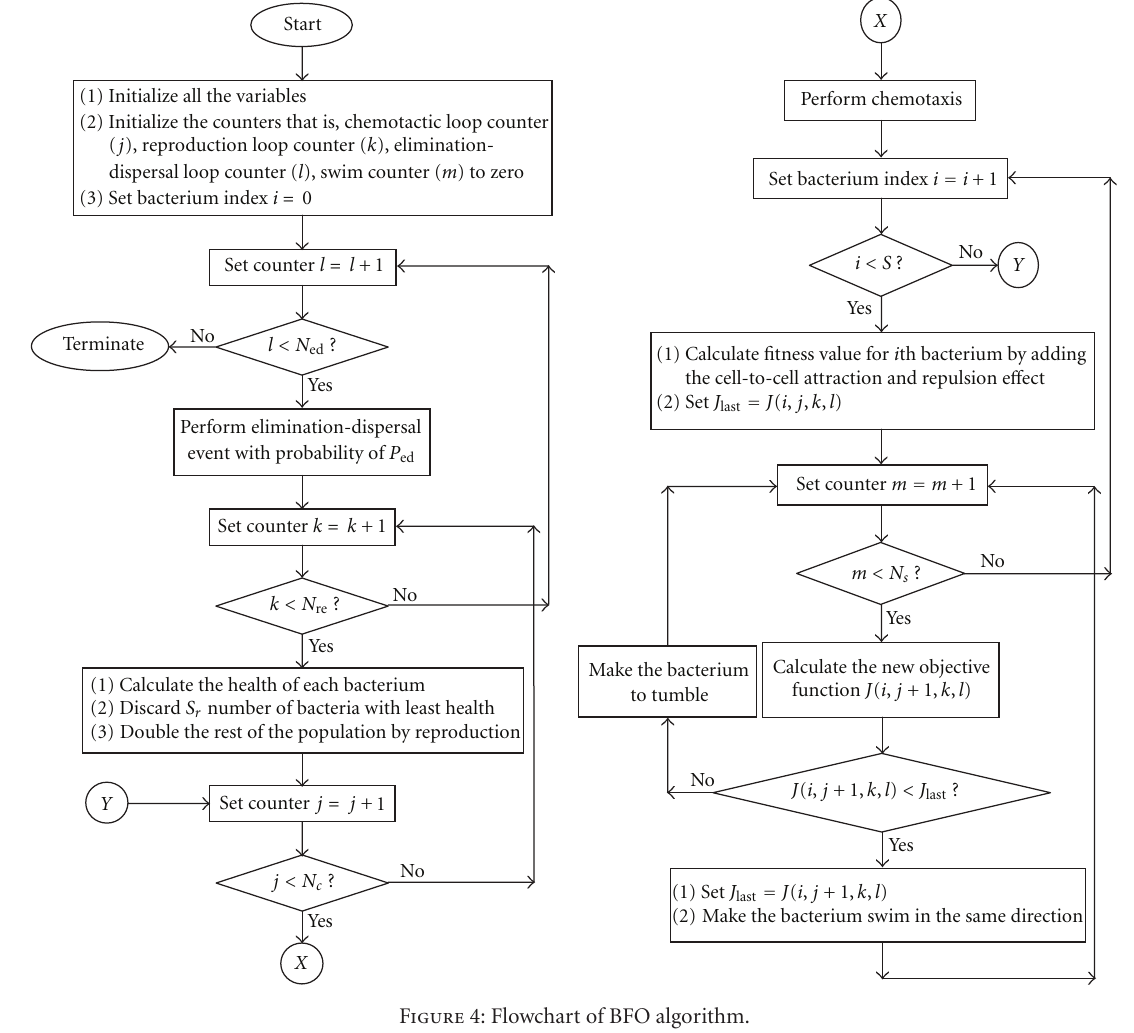
Figure 4: Flowchart of BFO algorithm.